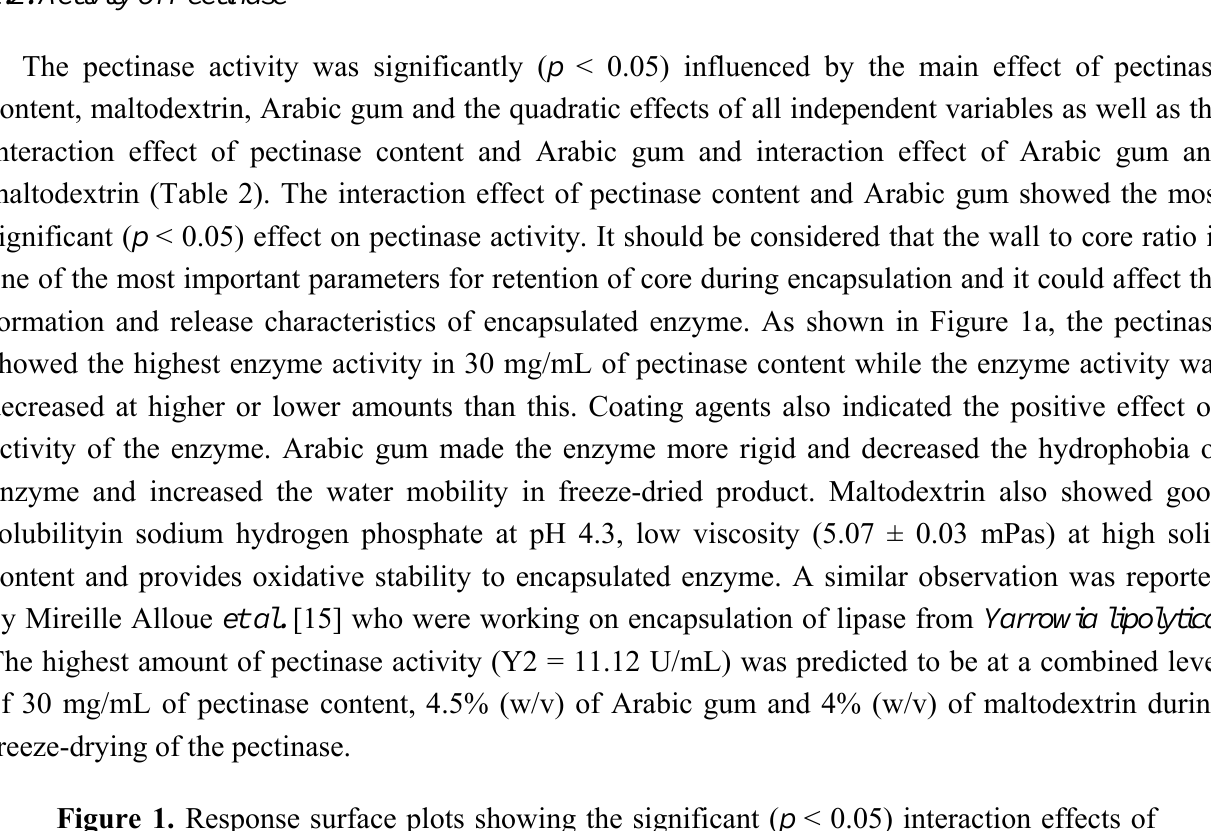
Figure 1. Response surface plots showing the significant ( p < 0.05) interaction effects of encapsulation factors on enzymatic properties of pectinase. ( a ) Surface plot of pectinase activity versus Arabic gum, pectinase content (U/mL); ( b ) Surface plot of yield (%) versus maltodextrin and Arabic gum; ( c ) Surface plot of storage stability (%) versus maltodextrin and Arabic